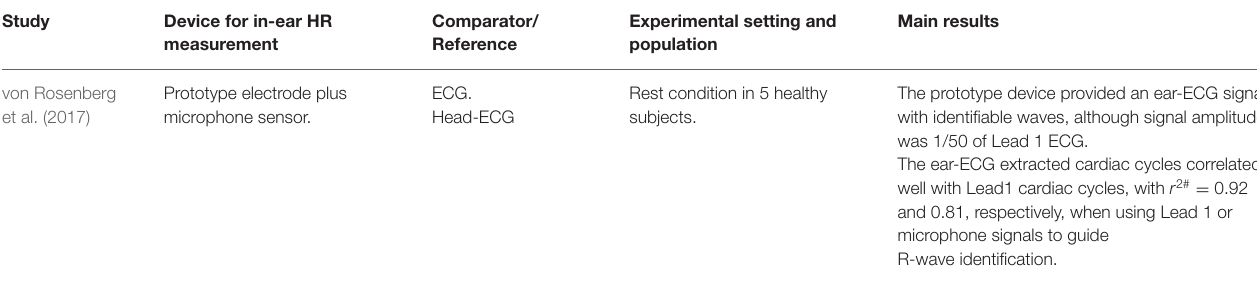
TABLE 4 | Included studies performing in-ear monitoring of oxygen peripheral saturation. Study Device for in-ear SpO 2 measurement